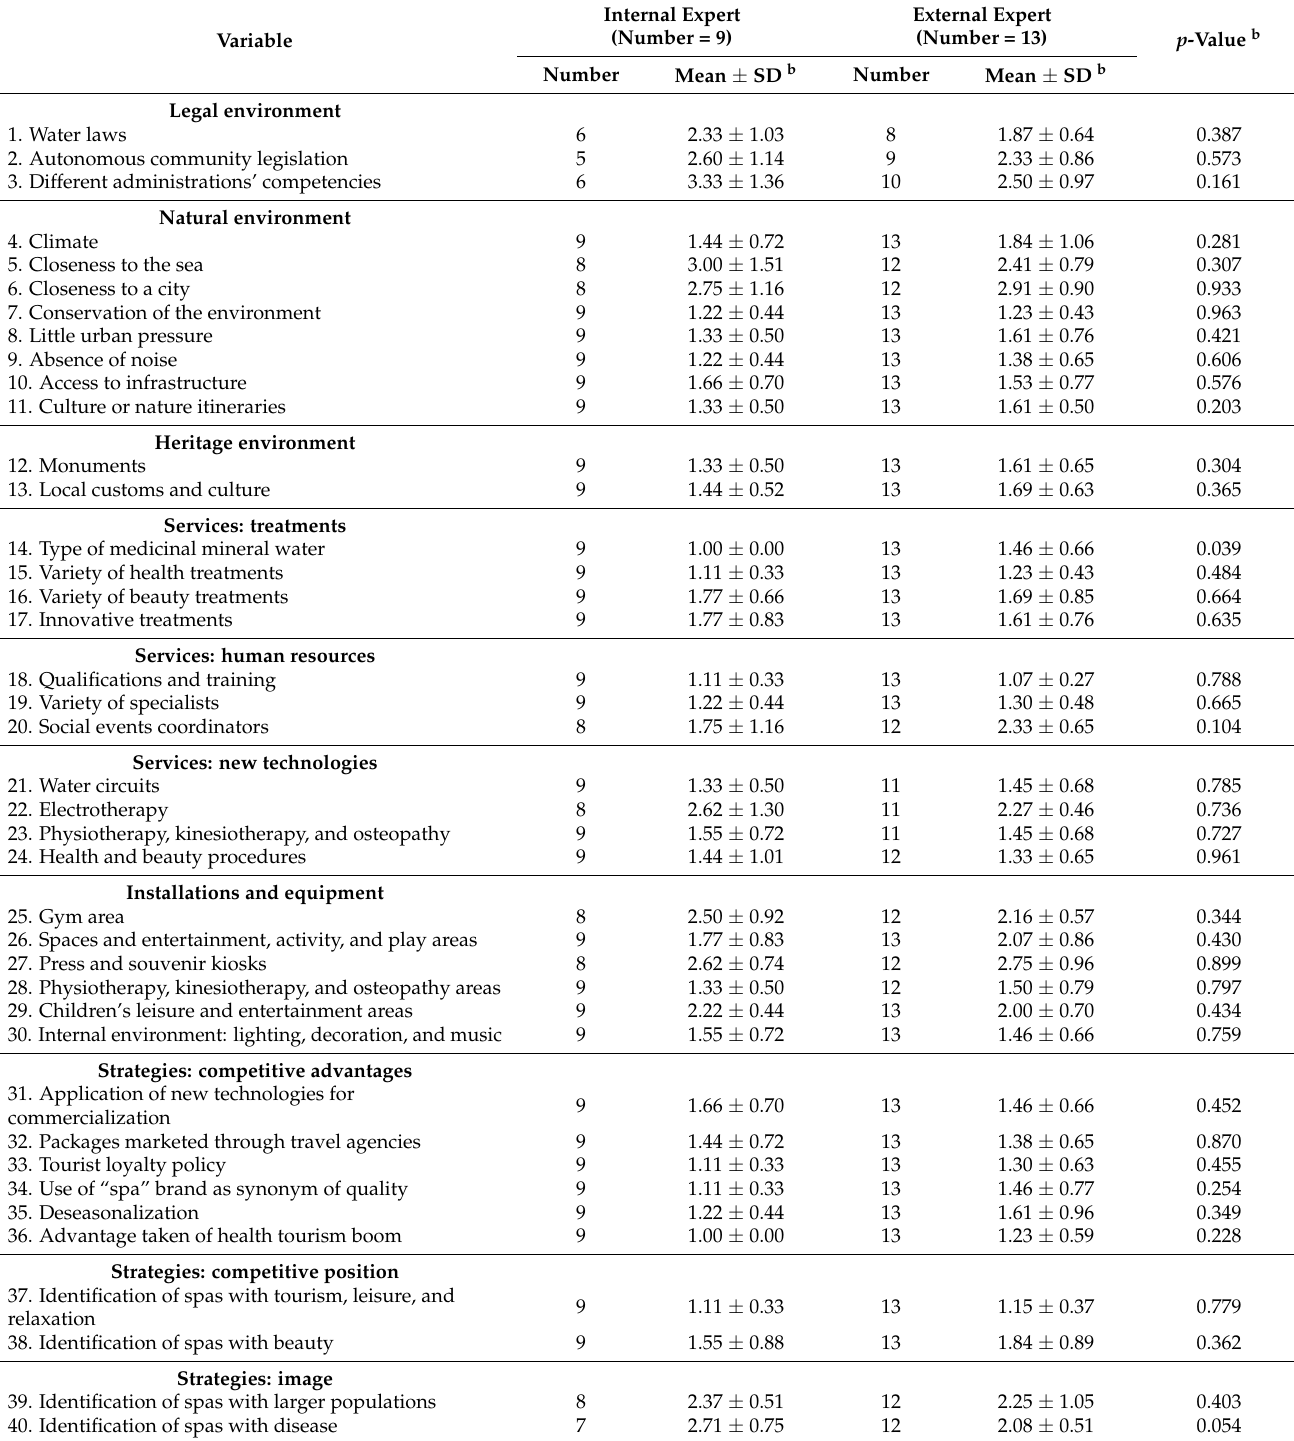
Table 6. Results of experts in thermal tourism in the second round according to type of expert ( n = 22) a .